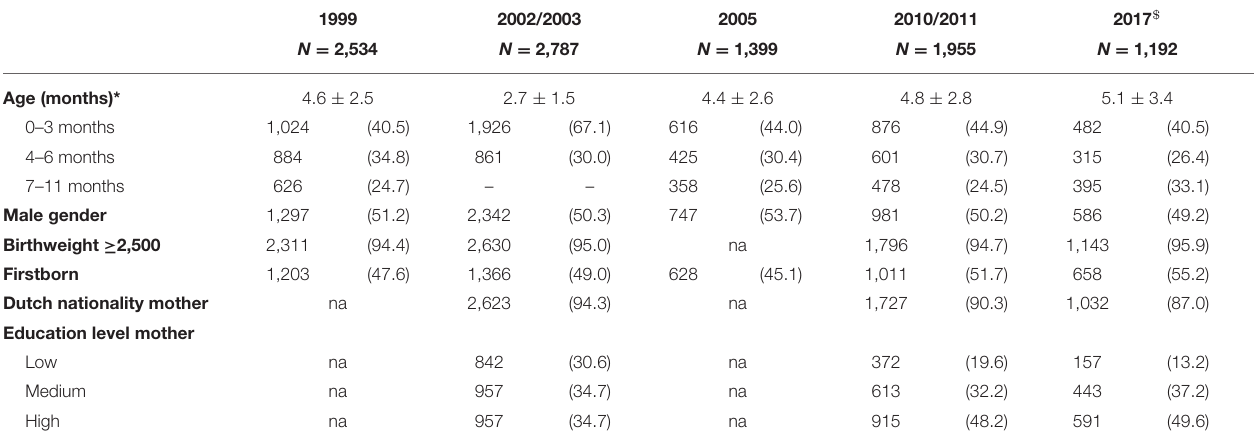
TABLE 2 | Characteristics of the five survey populations.